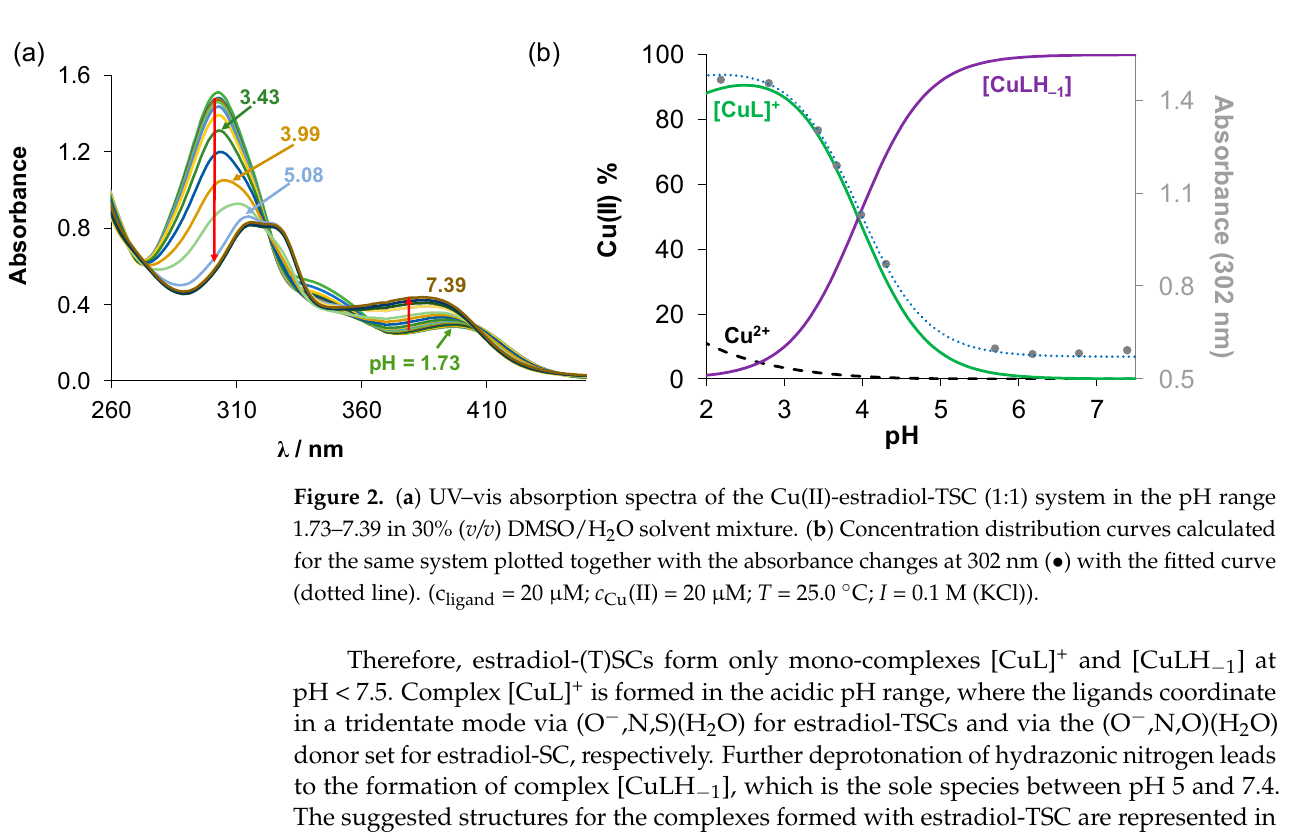
5 of 27 (T)SCs at pH 7.4 in H 2 O (1% ( v / v ) DMSO/H 2 O) emitting light in the 350 − 550 nm wave ‐ length range (Figure S3) [8,22,23]. 2.2. Complex Formation Equilibria of Estradiol ‐ (T)SCs with Cu(II) Ions and Their Structure In order to reveal the stability and speciation of the Cu(II) complexes of estradiol ‐ (T)SC, solution equilibrium studies were performed by UV–vis spectrophotometric titra ‐ tions in 30% ( v / v ) DMSO/H 2 O. The complex formation processes of the analogous estrone ‐ (T)SCs have already been investigated in our previous reports [8,22,23]; herein, similar binding modes and speciation are expected based on the close similarity of the chelating moieties of the ligands. Representative UV–vis spectra recorded for Cu(II) ‐ estradiol ‐ TSC and Cu(II) ‐ estradiol ‐ SC (1:1) systems are presented in Figure 2a and Figure S4a. Variation in the pH values reveals characteristic spectral changes in the UV–vis spectra and shows a single process up to pH 6.8, which is typical for deprotonation of hydrazonic nitrogen resulting in the (O − , N, S − ) binding mode [8,22]. Although fairly low ligand concentrations were used (20 μ M), some precipitate was observed at pH > ~8 using both 1:1 and 1:2 metal ‐